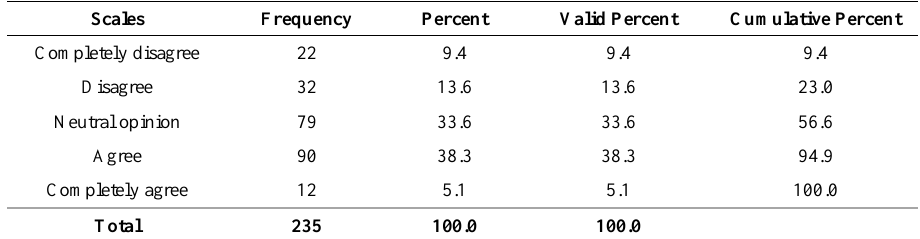
Table 3. Enterprises enhancing the financial